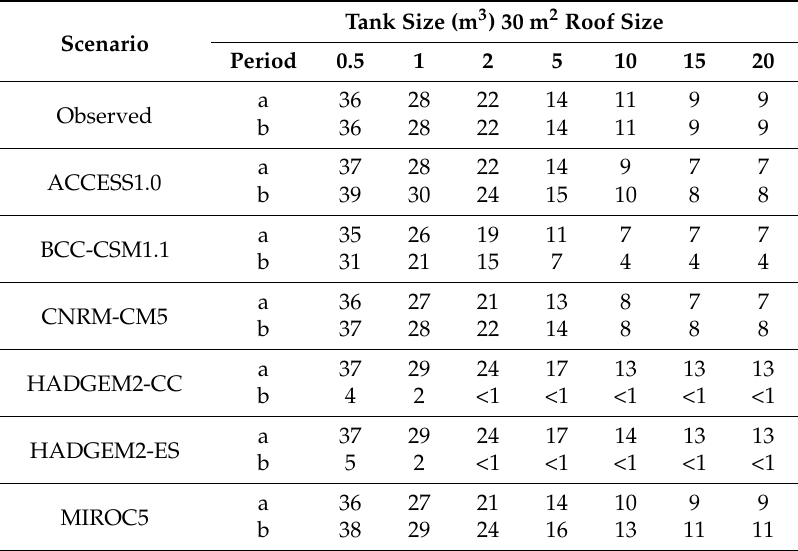
Table 7. Observed and projected water security for SON rain